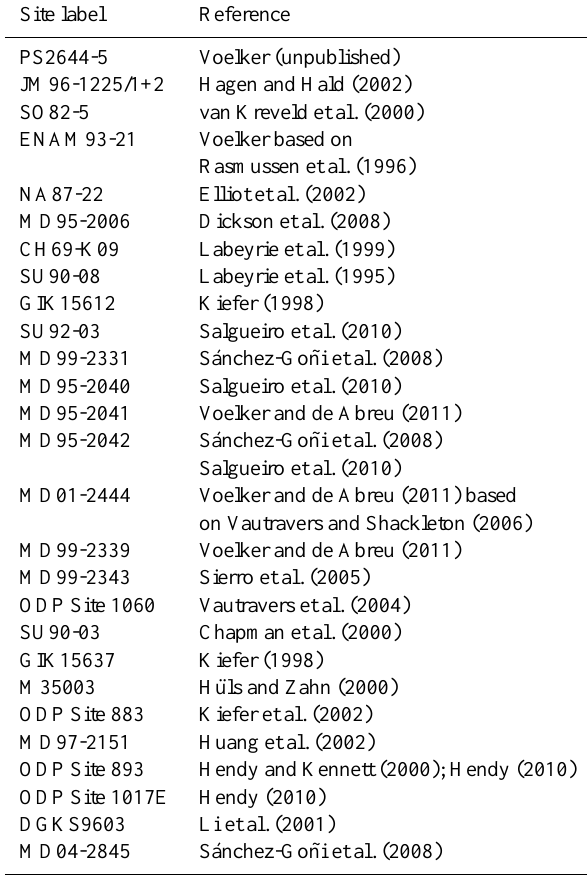
Table A2. Proxy records of SST based on the planktonic foraminifera fauna included in this study. Each record is identified by the site label.